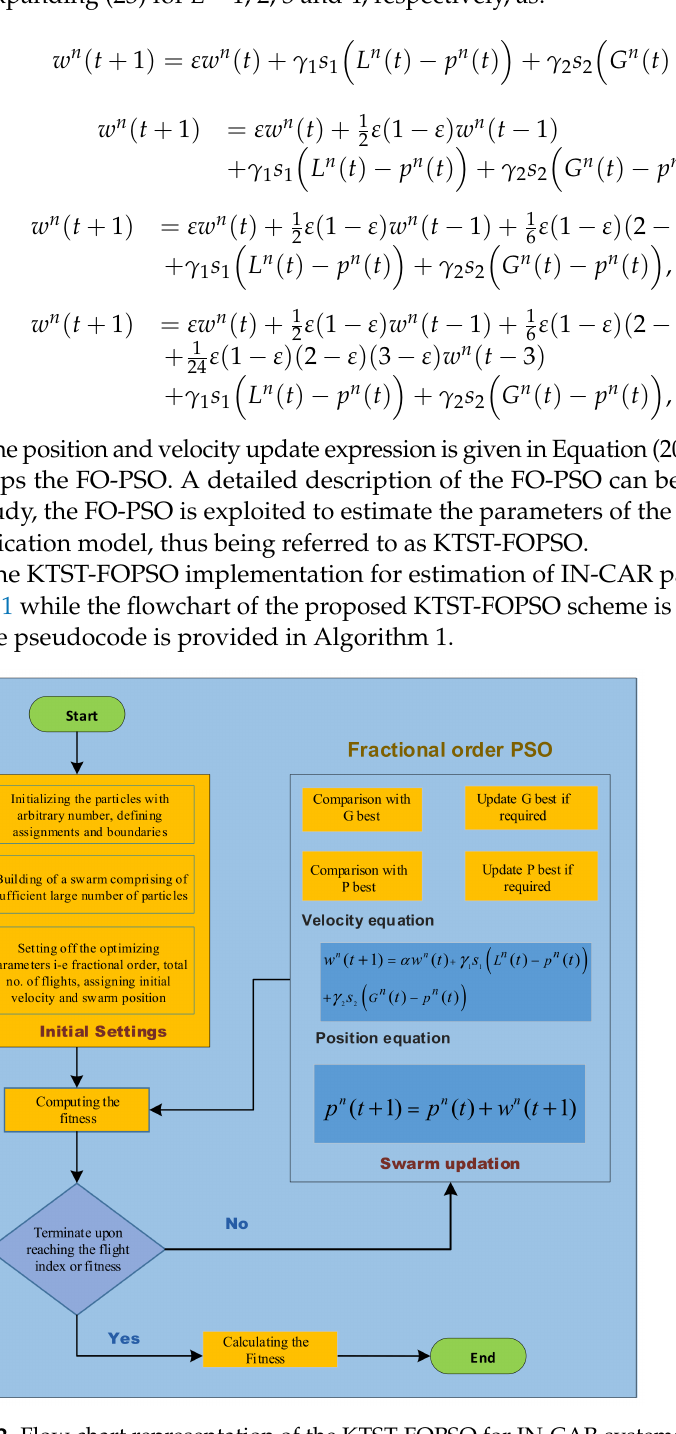
Figure 2. Flow chart representation of the KTST-FOPSO for IN-CAR